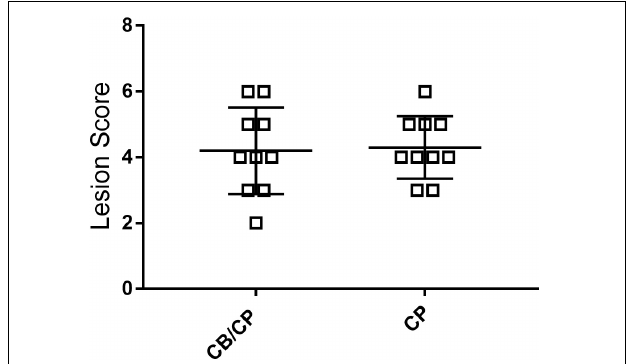
FIGURE 3 | Intestinal lesion scores of chickens after C. perfringens infection. Measured using ANOVA; n = 10. No intestinal lesion was found in the unchallenged groups.